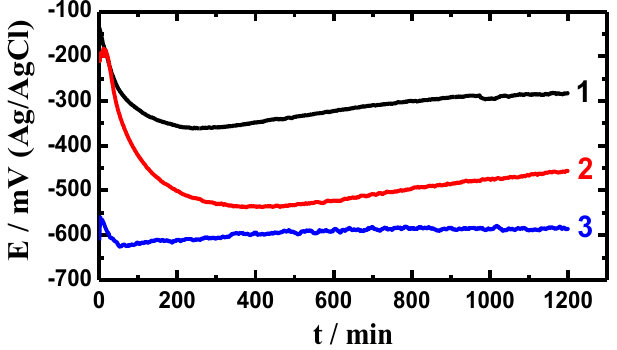
Figure 5. Change of the open circuit potential versus time curves obtained for the Al–TiC composite sintered at ( 1 ) 900, ( 2 ) 1100, and ( 3 ) 1300 °C in 3.5% NaCl